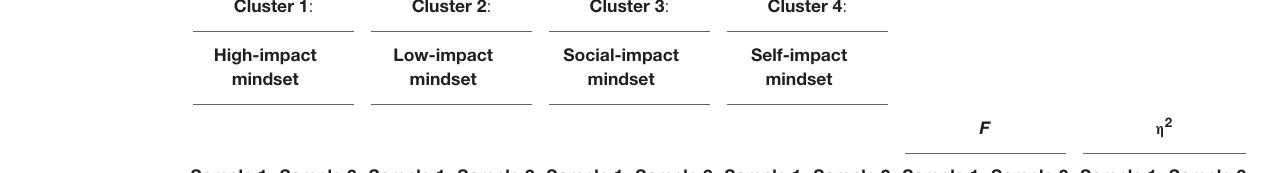
TABLE 4 | Cluster centers and multivariate analysis of variance. Cluster 1 : Cluster 2 : Cluster 3 : Cluster 4 :